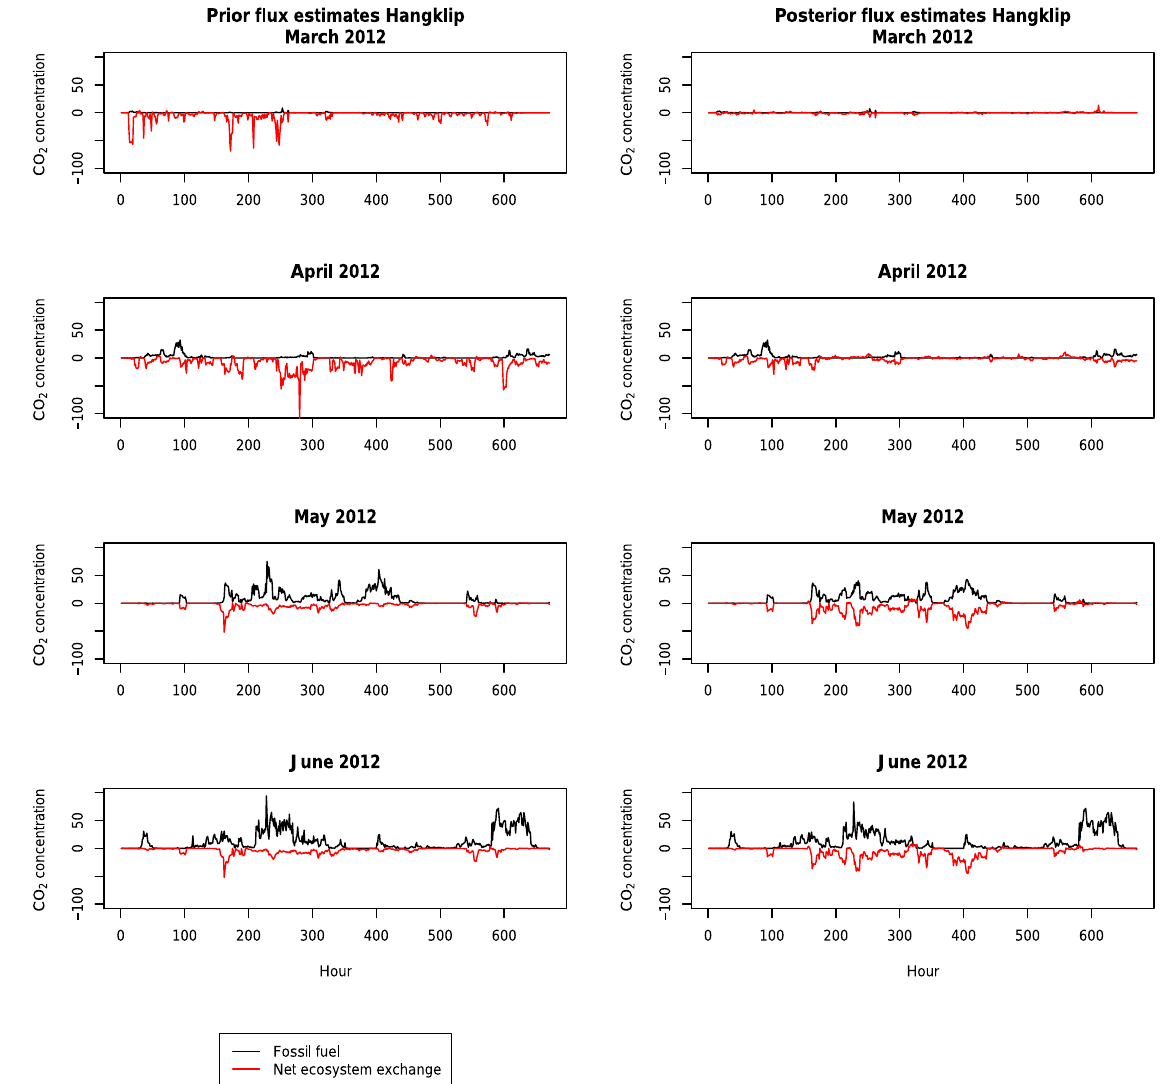
Figure 10. Prior and posterior contributions of the fossil fuel and NEE surface fluxes to the modelled CO 2 concentrations (ppm) at Hangklip from March 2012 until June